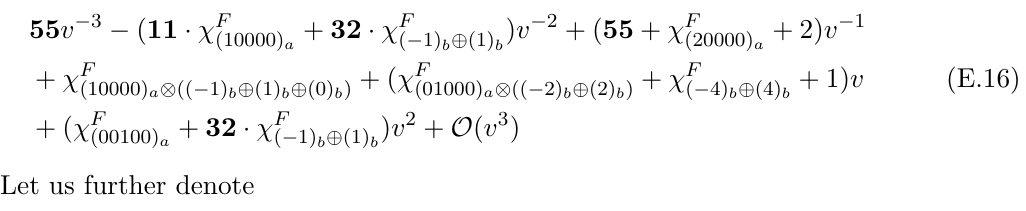
The subleading q order of reduced one-string elliptic genus